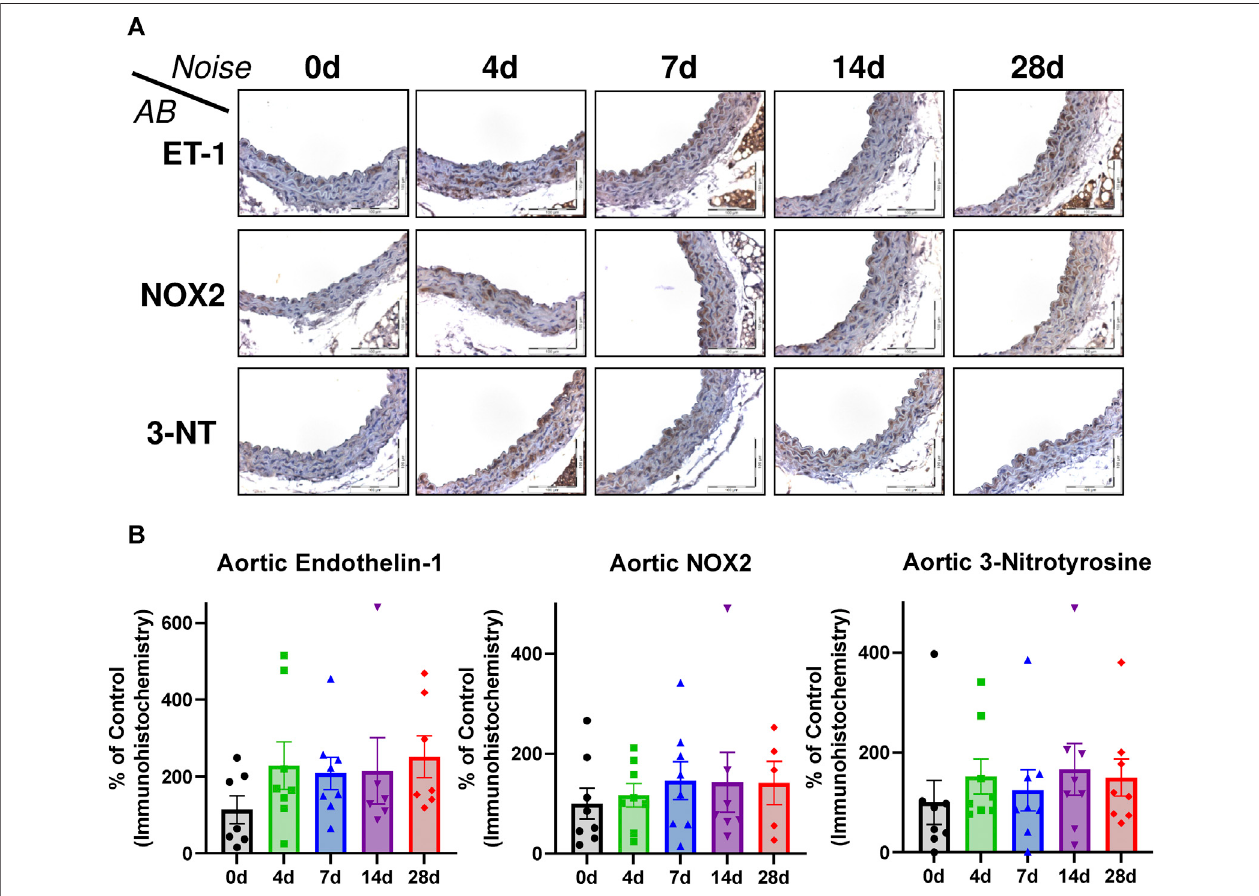
FIGURE 6 | Effects of long-term noise exposure on aortic immunohistochemistry for endothelin-1, NOX2 and 3-NT. (A) Representative immunohistochemical stainings of aortic paraf fi n sections (20x magni fi cation). (B) Densitometric quanti fi cation of immunohistochemical staining for ET-1, NOX2 and 3-NT in aortic tissue. Data points represent individual animals, n (cid:1) 5 – 8. Statistical analysis with one-way ANOVA with Tukey ’ s multiple comparison test revealed no signi fi cant differences.